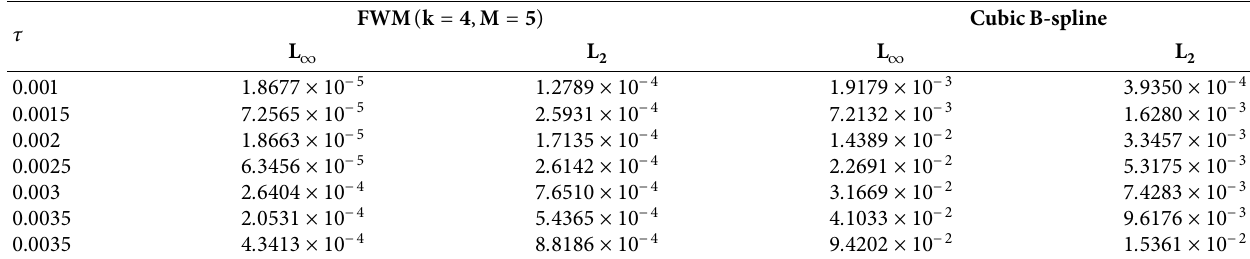
Table 6: Comparison of L k � 4 , M �